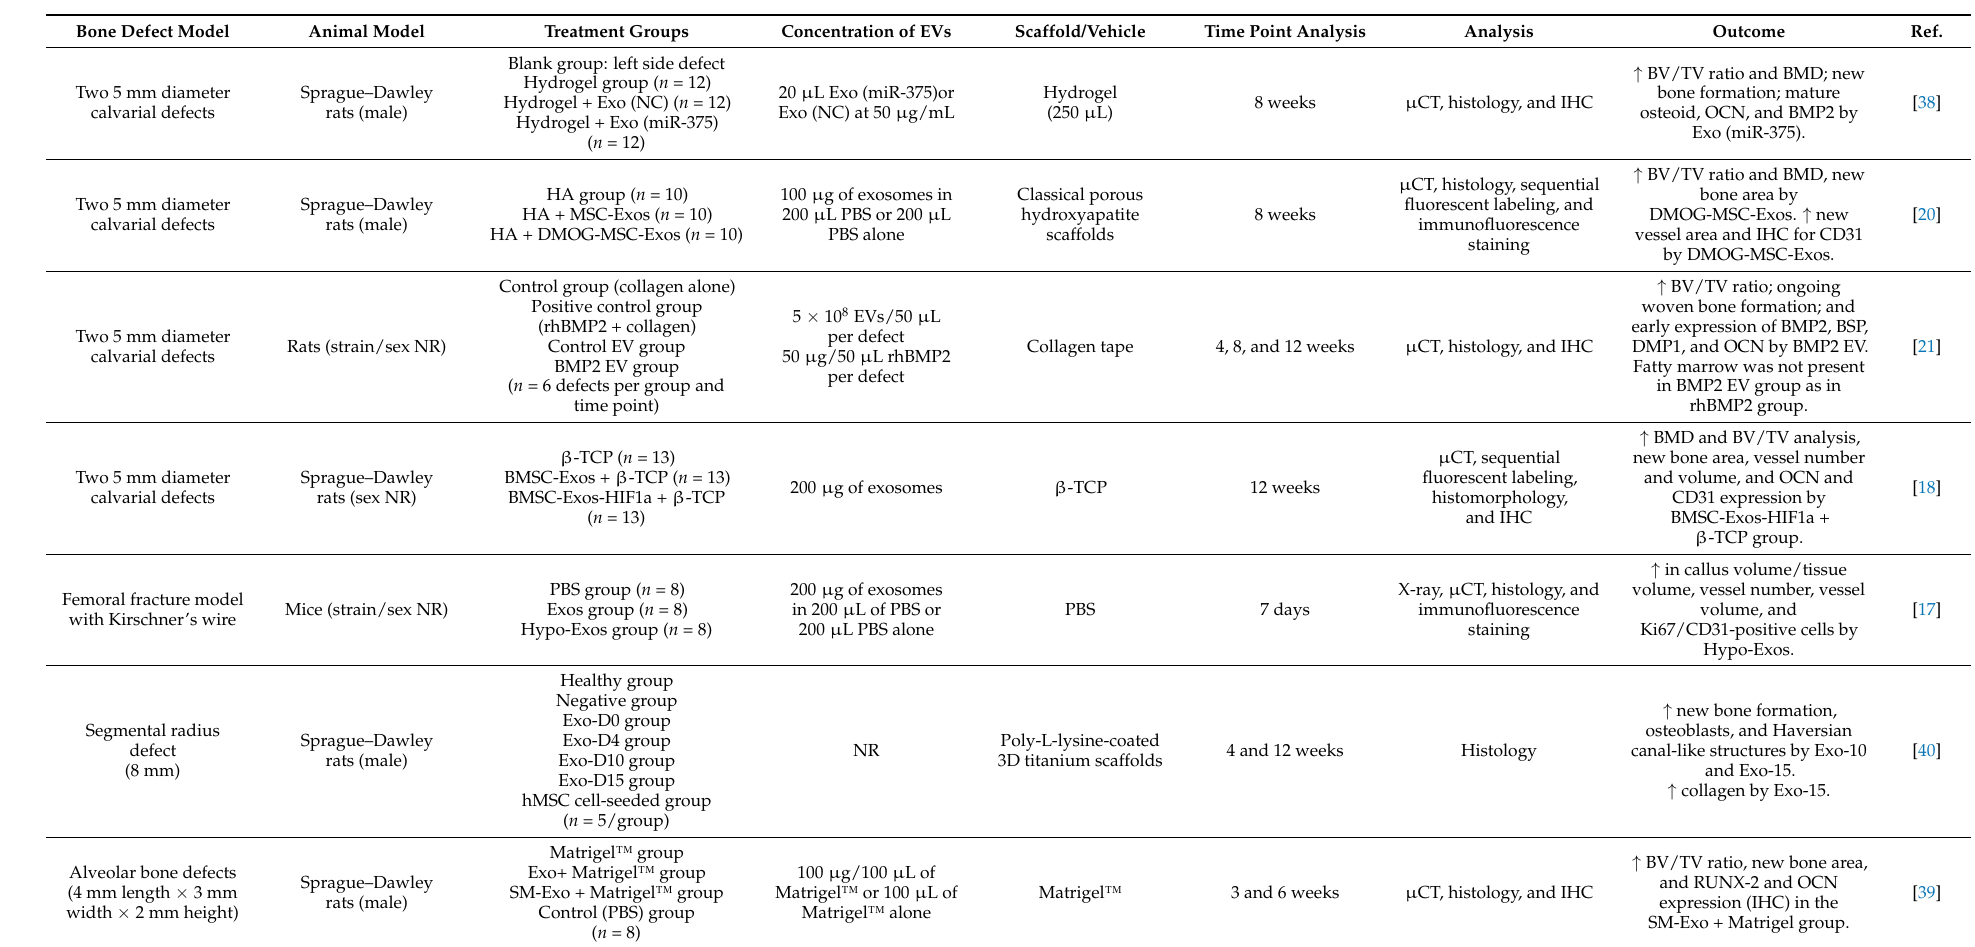
Table 4. Summary of in vivo methods and